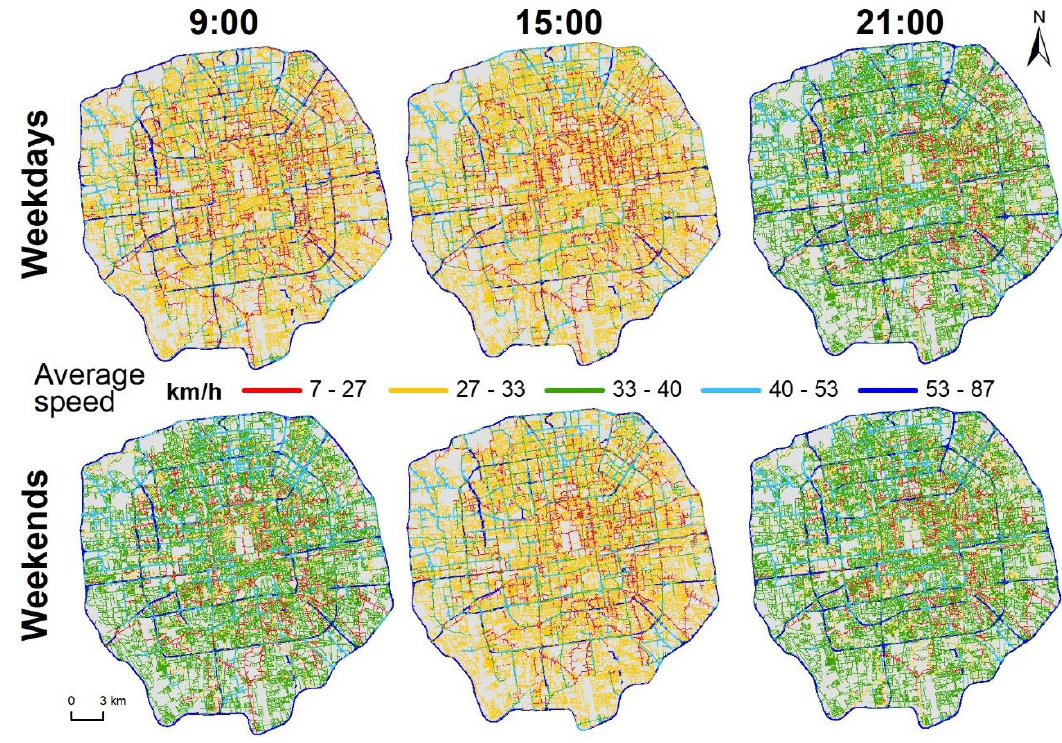
Figure 4. Speed at different times of each road in the study area.